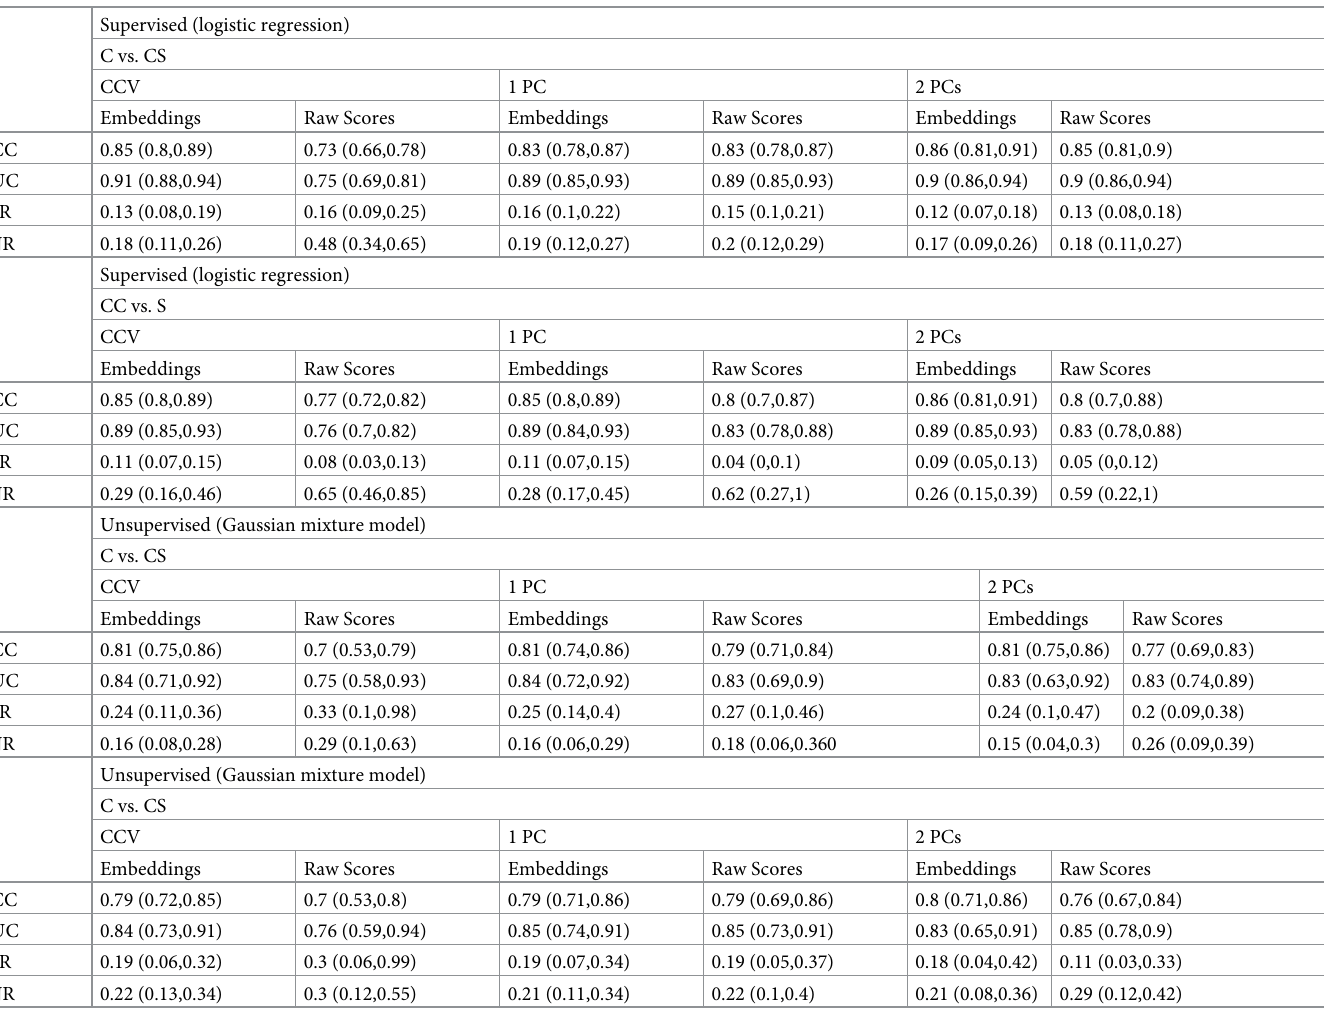
Table 1. Accuracy (ACC), AUC, false positive rate (FPR), and false negative rate (FNR) are obtained using supervised (logistic regression) and unsupervised (Gauss- ian mixture modeling) classification. All metrics are based on a probability of 0.5 classification threshold. Columns contain tables for clustering using the first canonical correlation variable and first n = 1, 2 principle components from the 9 questionnaires. Raw ordinal scores are used for comparison. Results are grouped into two column groups: the left group contains clustering comparing C vs. CS, the left group shows CC vs. S. Results for logistic regression are the mean of a 10-fold across-validation analysis.